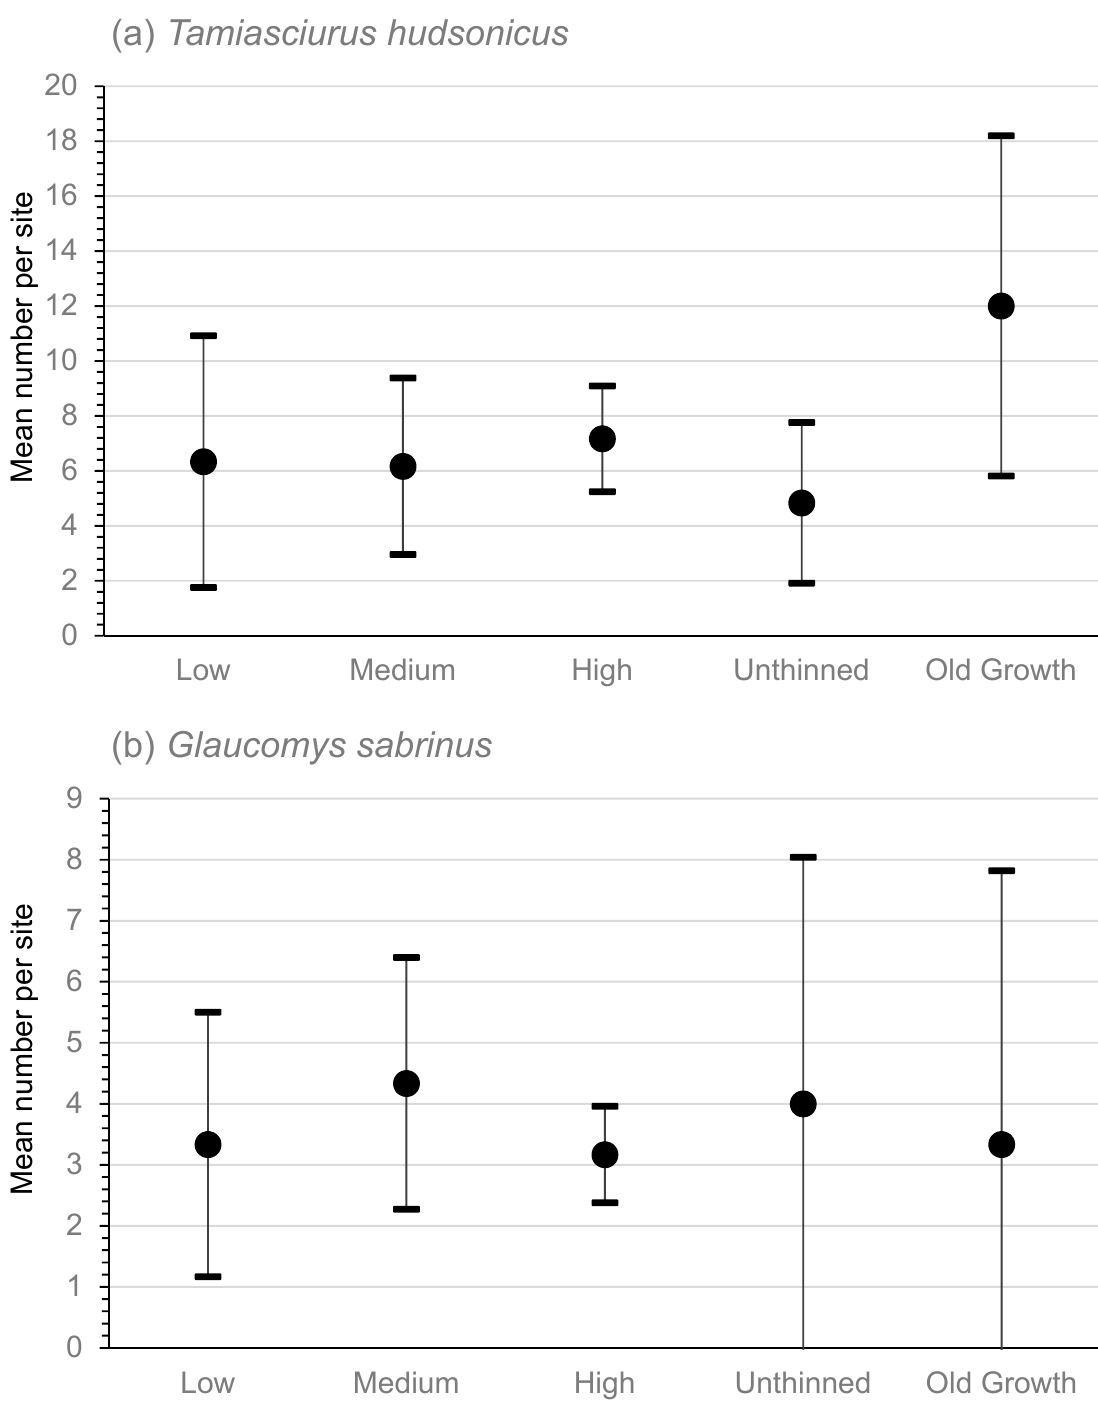
Figure 3. Mean ( n = 6; 3 replicate sites × 2 years) ± 95% CIs abundance as an index based on minimum number alive population estimates 2014 to 2015 in three thinned, unthinned, and old-growth stands in south-central British Columbia, Canada: ( a ) Tamiasciurus hudsonicus and ( b ) Glaucomys sabrinus. There were no significant interaction effects of treatment × time for either small mammals as a group or for tree